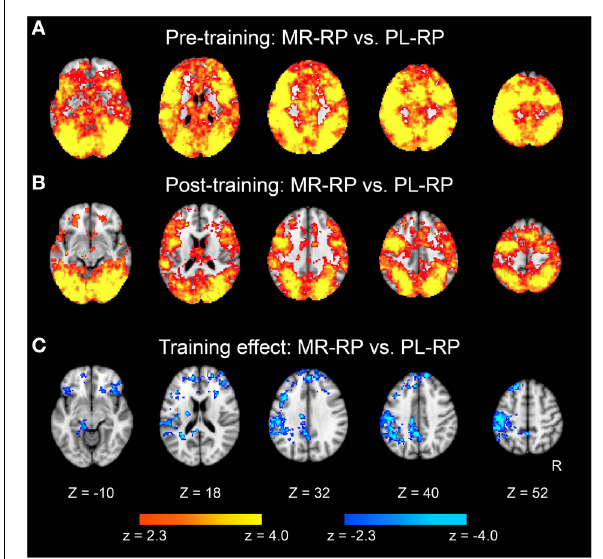
FIGURE 5 | Statistical significance maps for searchlight MVPA for Mirror-Repeat vs. Plain-Repeat trials ( P < 0 . 05 cluster size corrected). (A) Pre-training session. (B) Post-training session. (C) The difference in classification accuracy between pre- and post-training session. Cool color indicates decreased accuracy in post-training session. The formats are similar to those in Figures 3 , 4